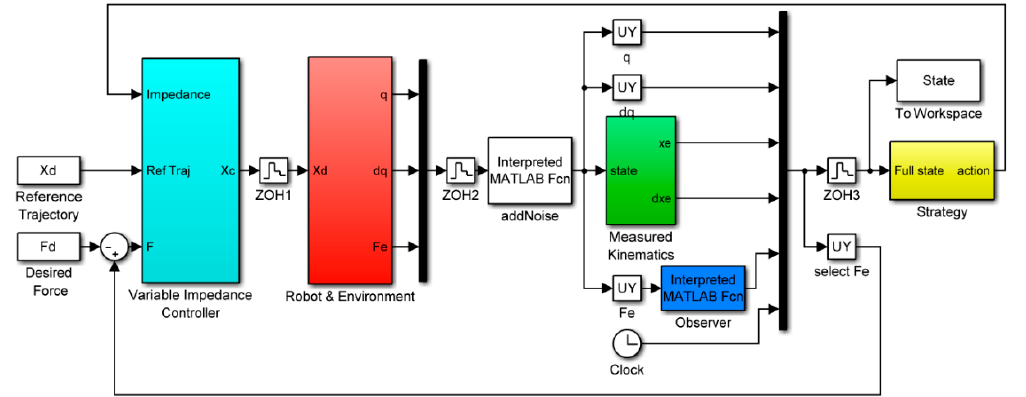
Figure 7. The block diagram of simulation in MATLAB Simulink.